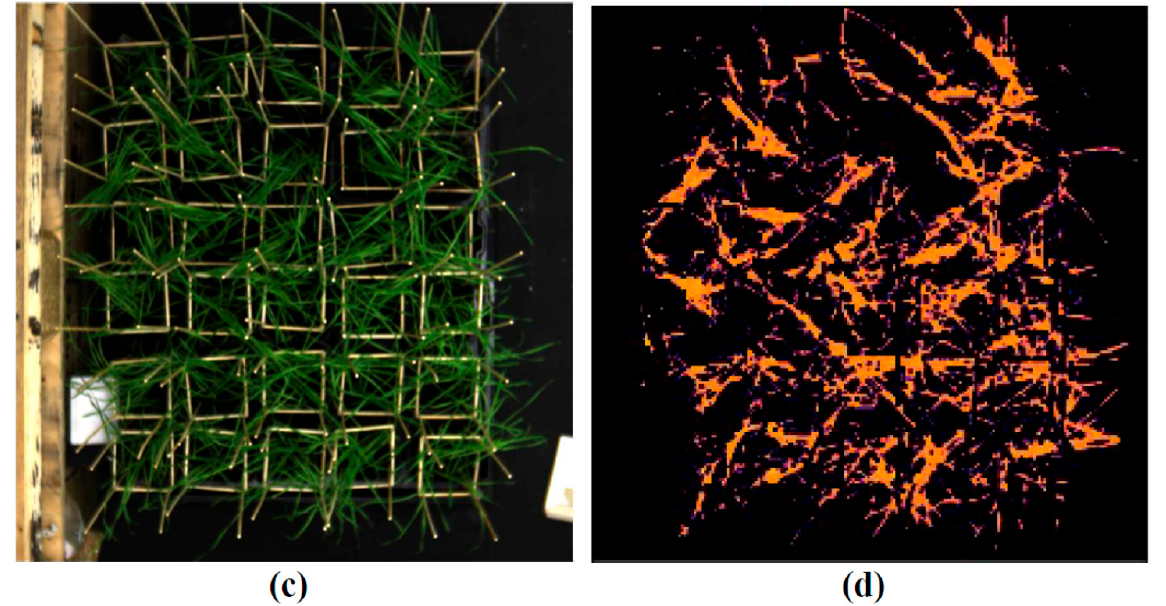
Figure 1. Examples of RGB image and pseudocolor RI image after excluding background. ( a ) RGB image of pea plants; ( b ) pseudocolor image of RI (670, 432) of pea plants; ( c ) RGB image of wheat plants; ( d ) pseudocolor image of RI (670, 432) of wheat plants. Plants cultivated in the vegetation room and measured at 90° angle to the ground plane (“View from above”) are shown.